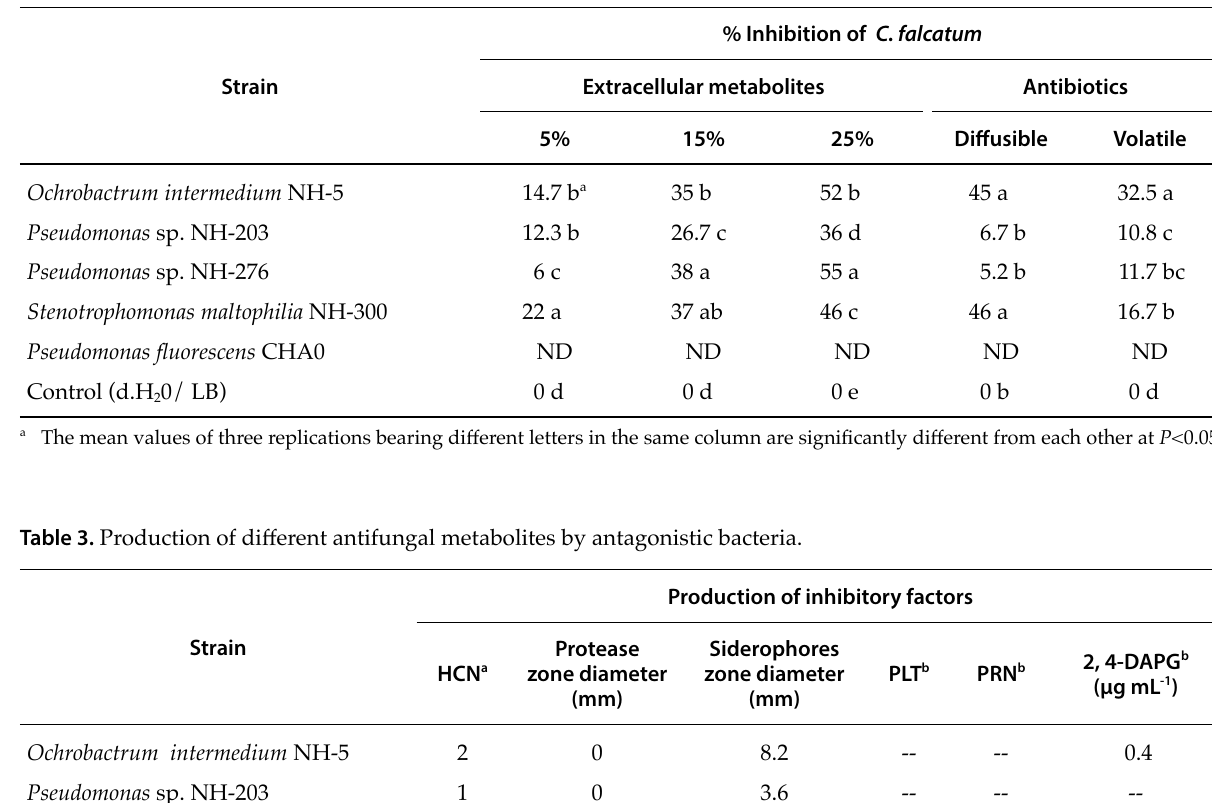
Table 2. In vitro inhibition of Colletotrichum falcatum by the extracellular metabolites and antibiotics produced by antago- nistic bacteria .